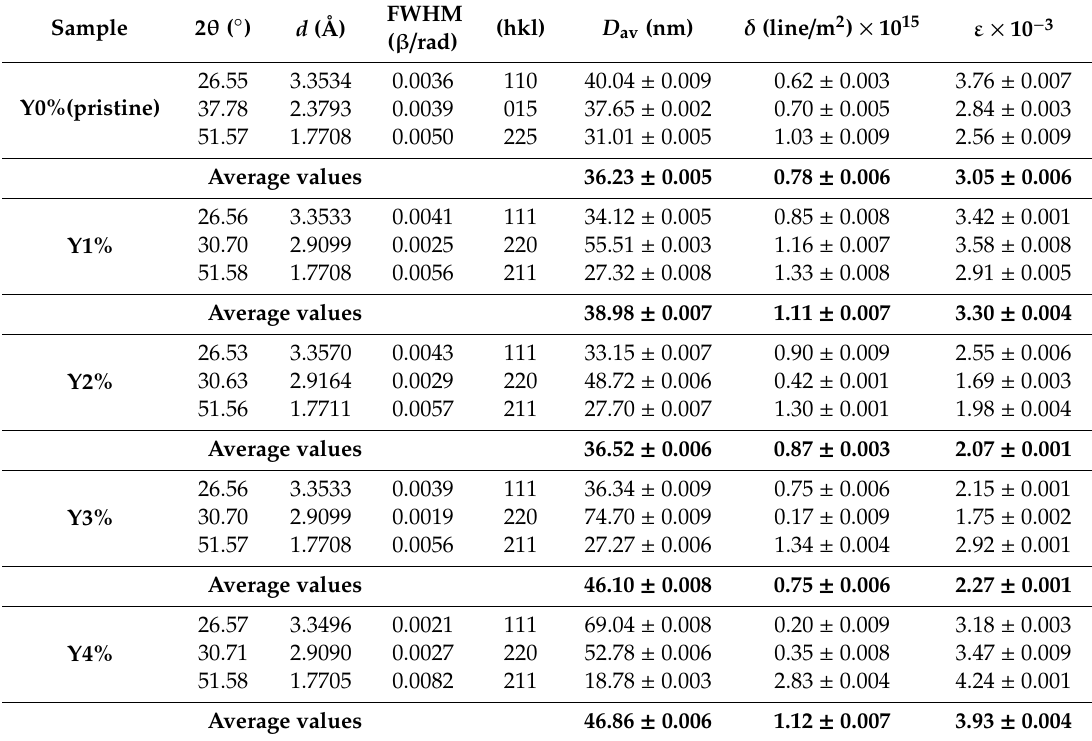
Table 1. Summary of crystal variables for pristine and composite